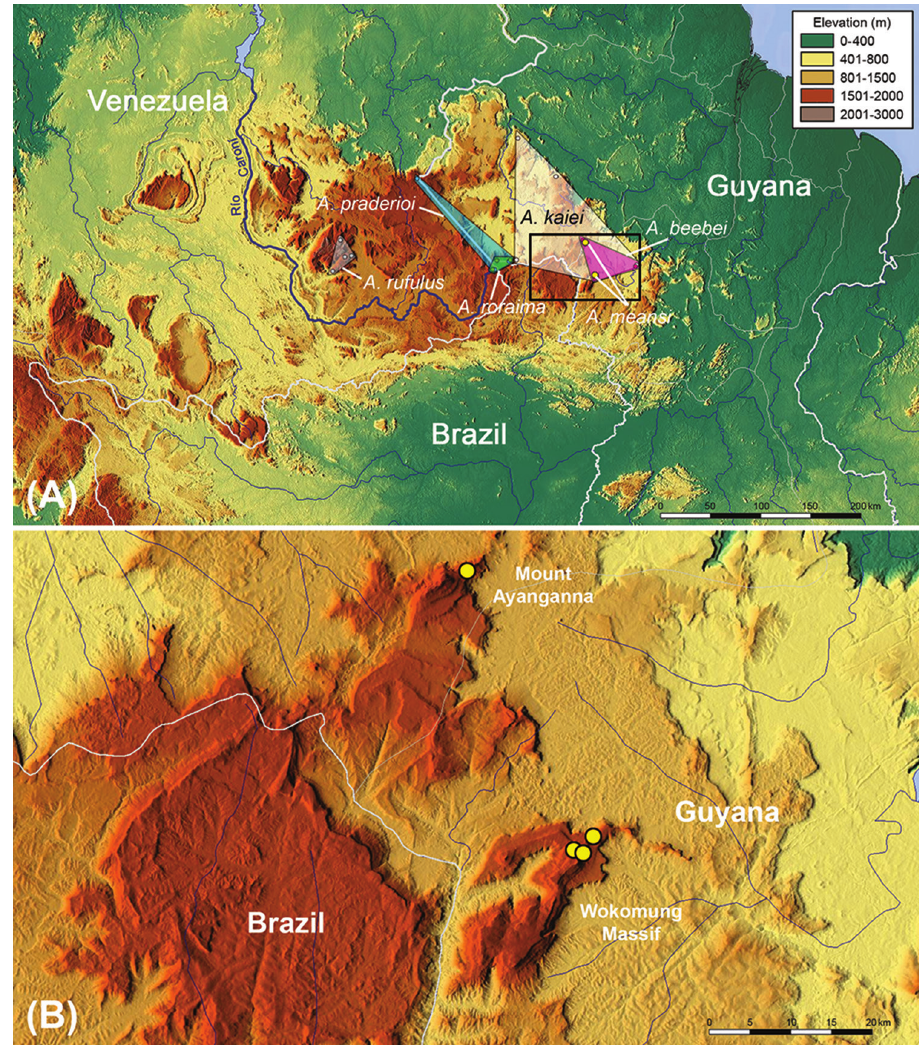
Figure 2. Occurrence map of the Anomaloglossus species belonging to the beebei group (coloured convex polygons); distribution of A. meansi sp. n. is depicted by yellow dots. A map of the Eastern Pantepui District; black rectangle is enlarged in B . B localities of occurrence of Anomaloglossus meansi sp. n. based on museum